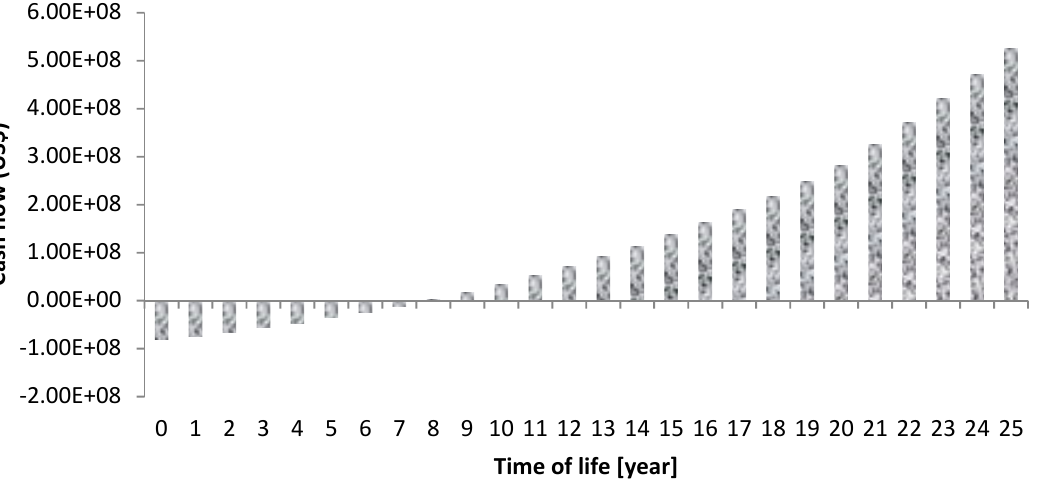
Figure 11. Cumulative cash flow for all projects.